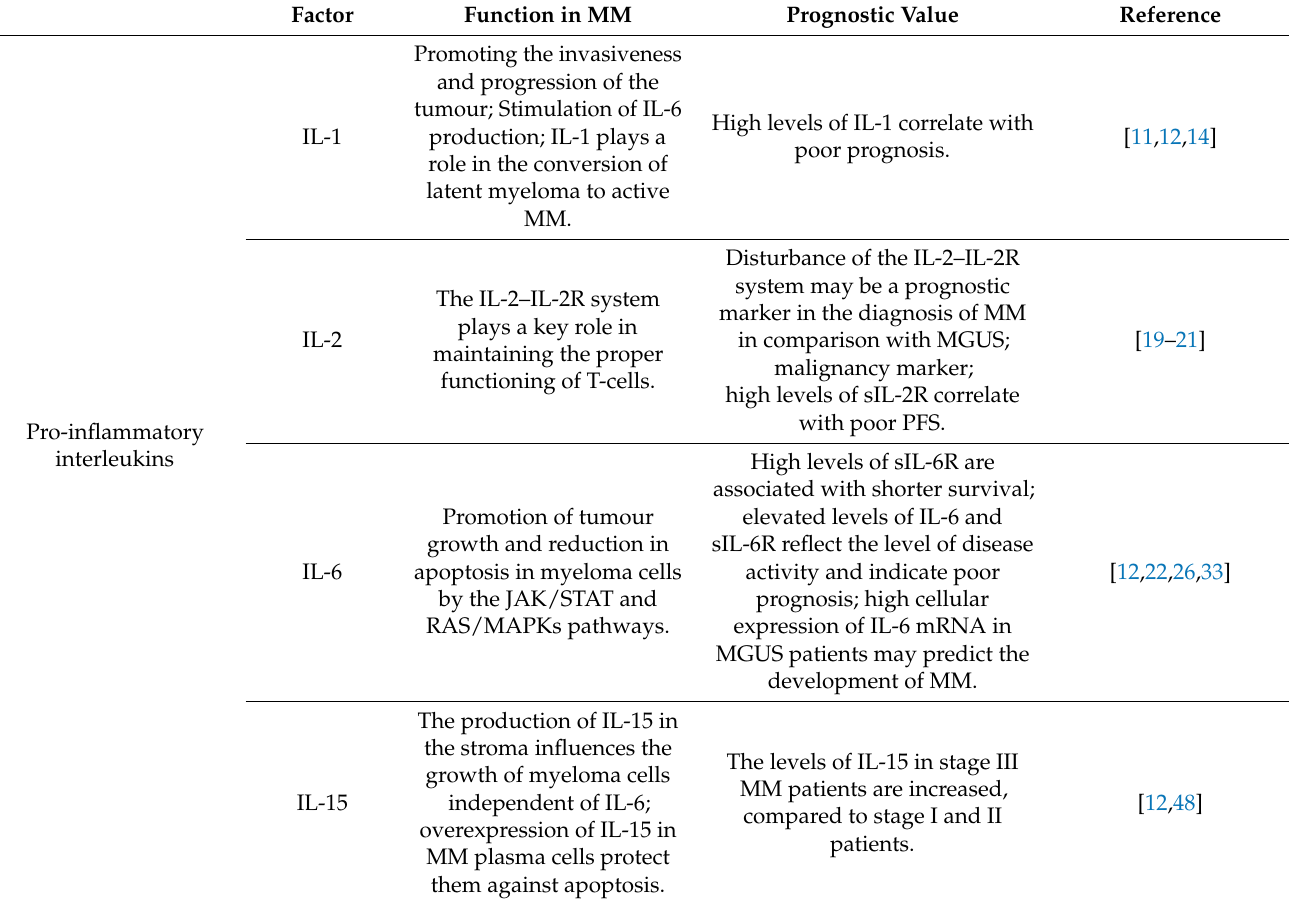
Table 1. Prognostic value of selected immune system elements in multiple myeloma